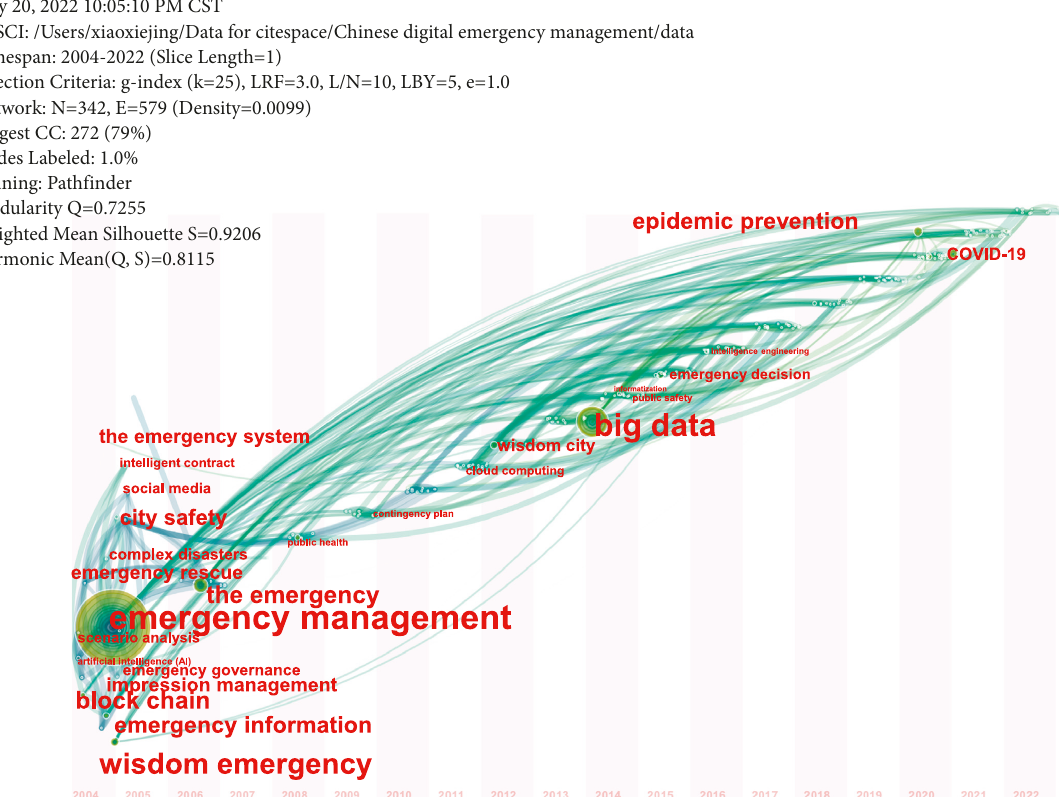
Figure 13: Time zone map of keywords of Chinese DEM